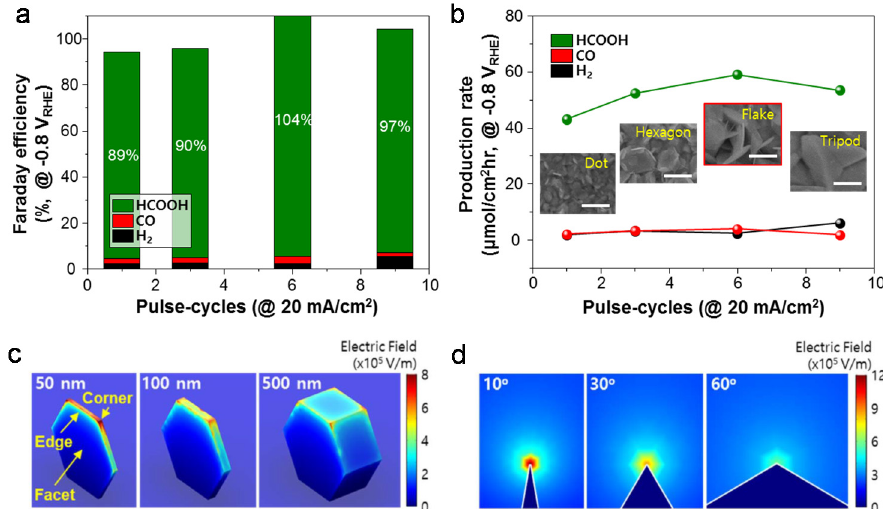
Figure 3. Performances of synthesized Bi nanostructures: ( a ) faradaic e ffi ciency (FE) and ( b ) production rate of pulse-current-deposited Bi films obtained at − 0.8 V vs. reversible hydrogen electrode (RHE) in CO 2 -purged 0.1 M KHCO 3 electrolyte. The insets in ( b ) are SEM images of pulse-current-deposited Bi films fabricated with di ff erent pulse cycles at 20 mA cm − 2 . Simulated electric field distribution in ( c ) three-dimensional and ( d ) two-dimensional Bi nanostructures [31]. Copyright 2017, Elsevier.